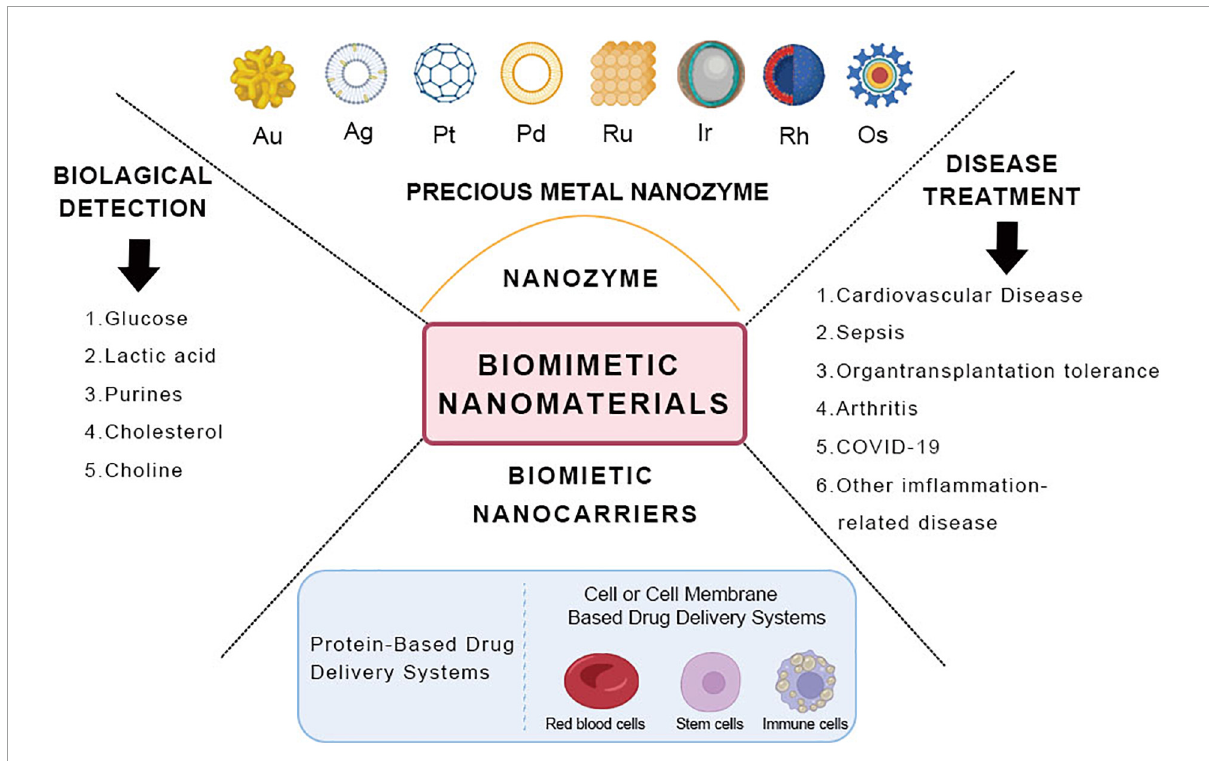
FIGURE1 Schematic diagram of the classification and application of biomimetic